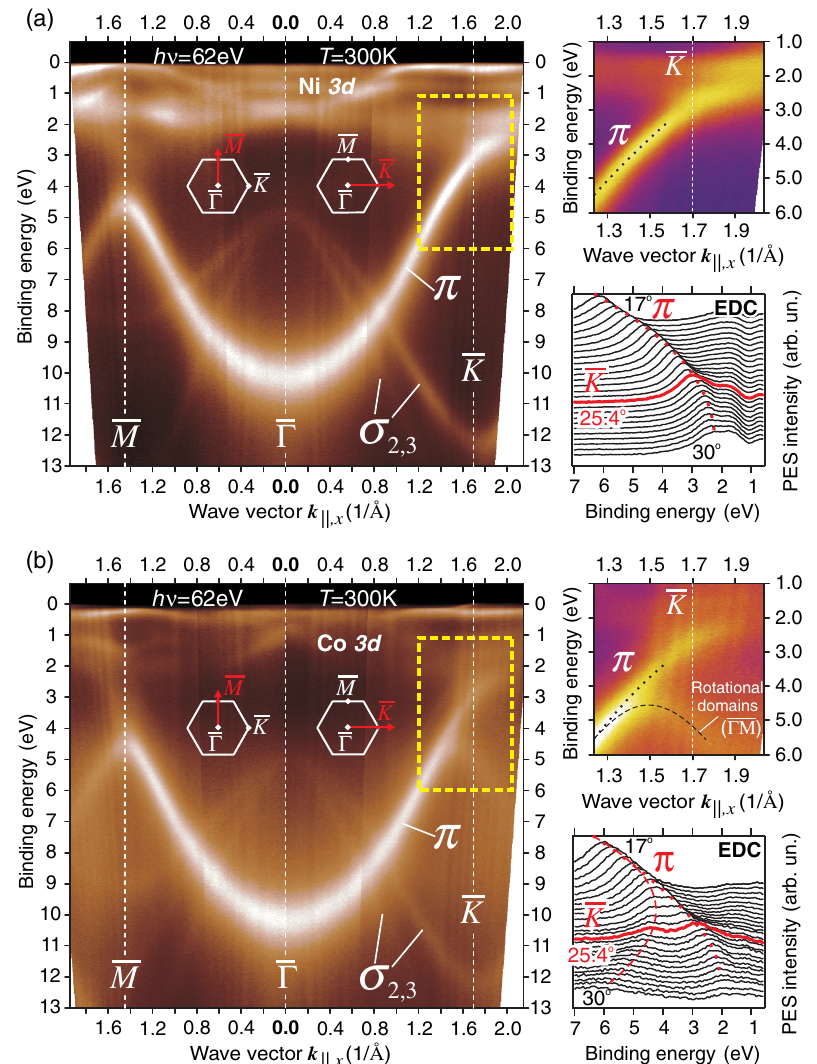
FIG. 2. ARPES characterization of the gapless dispersion through the (cid:1) K point from (cid:1)(cid:5) . Overall band structures of graphene on (a) Ni(111) and on (b) Co(0001) measured along the (cid:5) M and (cid:5) K directions of the surface Brillouin zone. The insets on the right-hand side of (a) and (b) emphasize the gapless dispersion of the (cid:1) band at the (cid:1) K